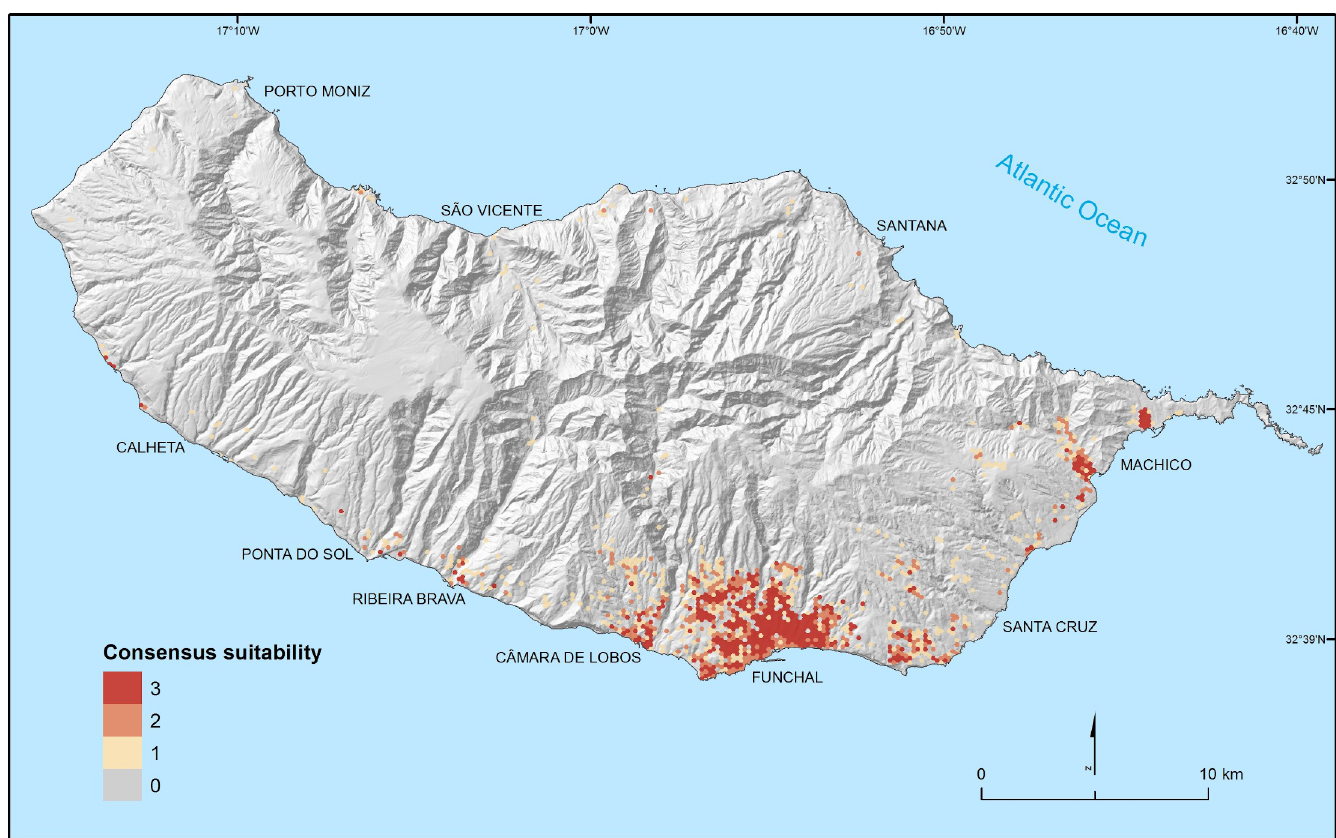
Fig 6. Suitability of land use and human settlement conditions for Aedes aegypti on Madeira Island. The highest (lowest) value indicates areas predicted as suitable (unsuitable) by all three algorithms: boosted regression trees, generalized linear models and random forests (generalized additive models were not used as the number of distribution records was insufficient for model fitting). Intermediate values reflect disagreement between models and correspond to areas of higher uncertainty on the suitability of conditions (source of shapefile: https://www.dgterritorio.gov.pt/cartografia/cartografia-tematica/caop).